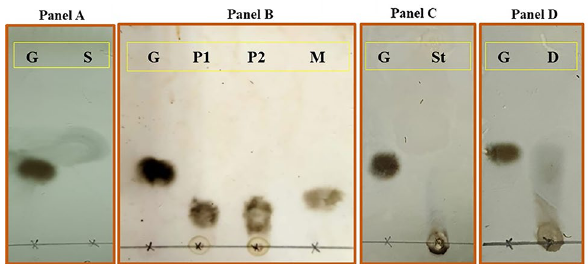
Fig. 4 TLC showing pullulan end products hydrolysis by Pull_Met. Panel A : G: glucose standard. S: undigested pullulan substrate. Panel B : G: glucose standard, M: maltose standard, P1: pullulan end products of hydrolysis (5 µL) and P2 pullulan end products of hydrolysis (10 µL): by Pull_Met. Panel C : G: glucose standard. St: standard end products of starch hydrolysis. Panel D : G: glucose standard, D : Dextrin end products of